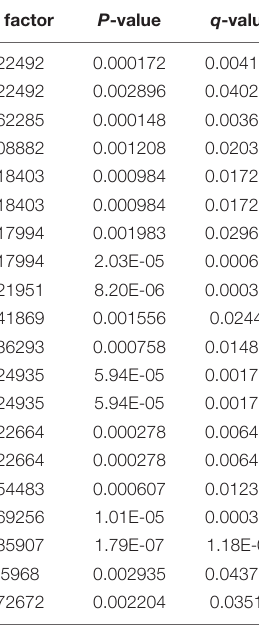
TABLE 6 | The classification corresponding to the top 10 DEmRNAs at 4 and 7 days after sciatic nerve crush injury in SD rats in the GO analysis.